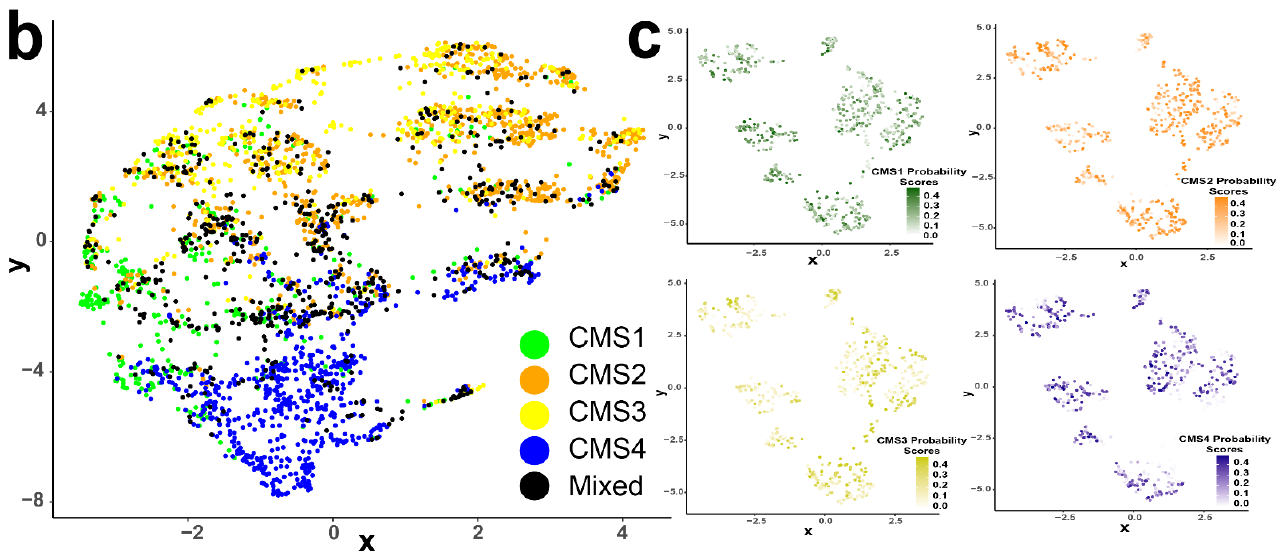
Figure 3. ( a ) Heatmap plot of normalized enrichment scores of 27 marker gene sets across 3232 CRC samples. ( b ) UMAP plot of all CRC patients projecting the distribution of different CMSs. ( c ) UMAP plots of tumor samples of mixed group depicting the distributions of all four CMS probability scores.